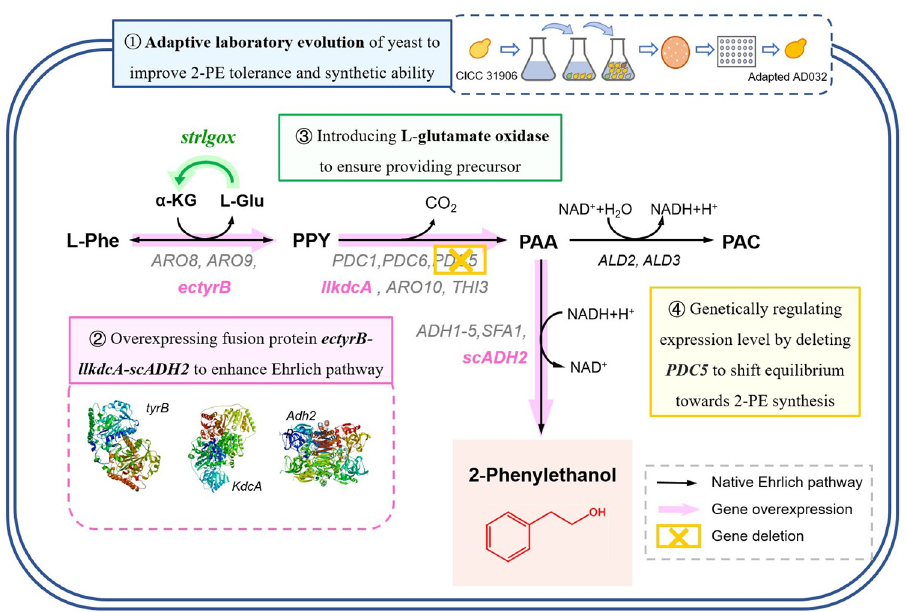
Fig 1. A holistic view of the engineering route in S . cerevisiae to effective 2-PE producer through Ehrlich pathway. Four categories of methods for manipulating the flux from L-phenylalanine to 2-phenylethanol were grouped and shown respectively. Metabolite abbreviations: L-Phe, L-phenylalanine; PPY, phenylpyruvate; PAA, phenylacetaldehyde; PAC, phenylacetate; 2-PE, 2-phenylethanol. Genes and enzymes: ARO8 , ARO9 , tyrB , aromatic aminotransferase; PDC1 , PDC5 , PDC6 , pyruvate decarboxylase; ARO10 , THI3 , kdcA , phenylpyruvate decarboxylase; ALD2 , ALD3 , acetaldehyde dehydrogenase; ADH1 , ADH2 , ADH3 , ADH4 , ADH5 , SFA1 , alcohol dehydrogenase; lgox , L-glutamate